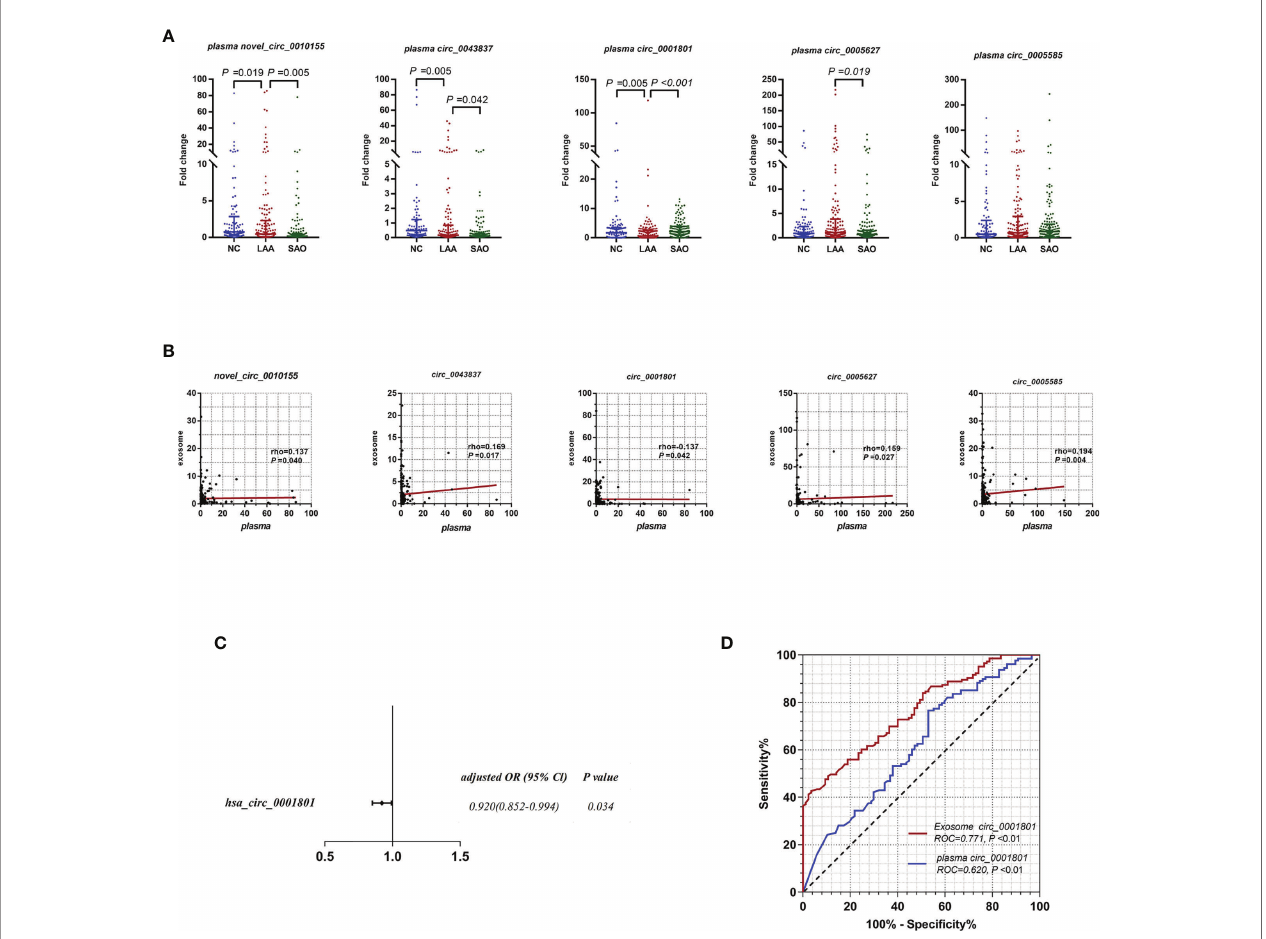
FIGURE 3 | Diagnostic ef fi cacy of LAA stroke comparison between exosome derived circRNA and plasma circRNAs. (A) Replication of plasma novel_circ_0010155, circ_0043837, circ_0001801, circ_0005627, and circ_0005585 in NC, LAA, and SAO groups. (B) Correlation between the assessment of